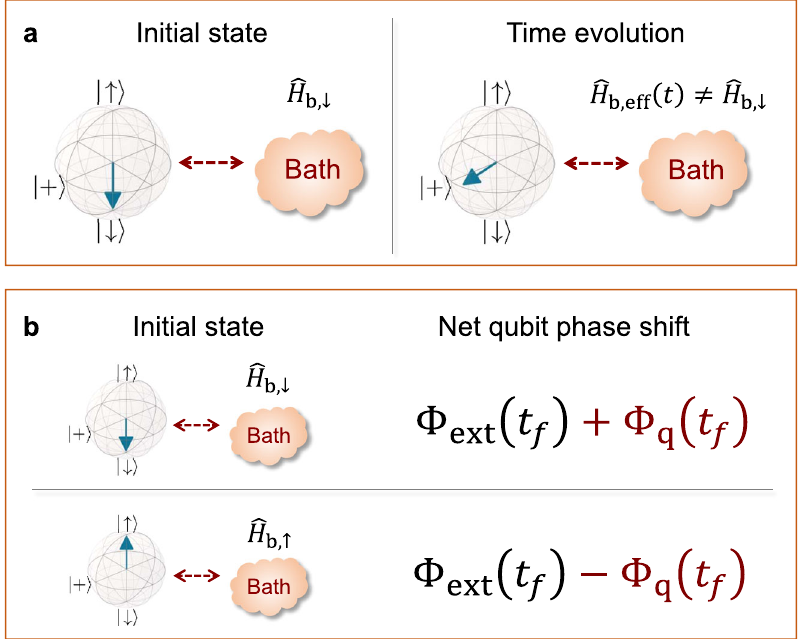
Fig. 1 Quantum quenches in standard dephasing-based quantum sensing (noise spectroscopy) protocols. a Schematic illustrating an intrinsic quantum quench arising in standard T 2 -type experiments, where the effective bath Hamiltonian undergoes a sudden change at the start of the protocol, c.f. Eqs. (5) and (6). b The quench manifests itself as an additional quench phase shift (QPS) Φ q ( t f ) of the sensor qubit. The QPS can be distinguished from a phase Φ t fi eld: in the simplest case, it is crucially sensitive to the initial qubit state before the start of the sensing f ) resulting from an external ext (